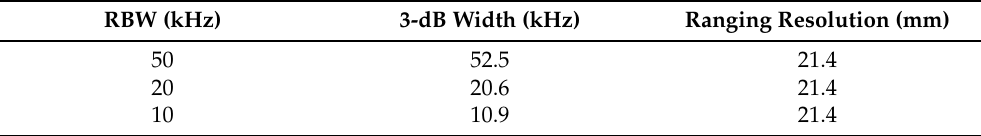
Figure 8. Experimental setup for exploring ranging resolution. VODL: variable optical delay line. Table 2. The 3-dB bandwidth and the ranging resolution under different